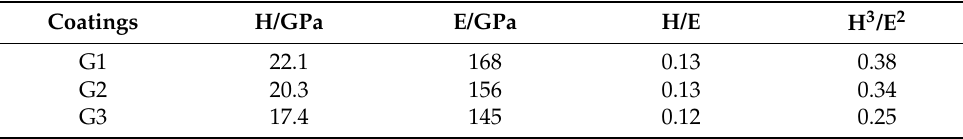
Figure 3. TEM surface morphology and the corresponding SAED images ( a , d ) G1; ( b , e ) G2; and ( c , f ) G3. Table 2. Mechanical properties of the DLC